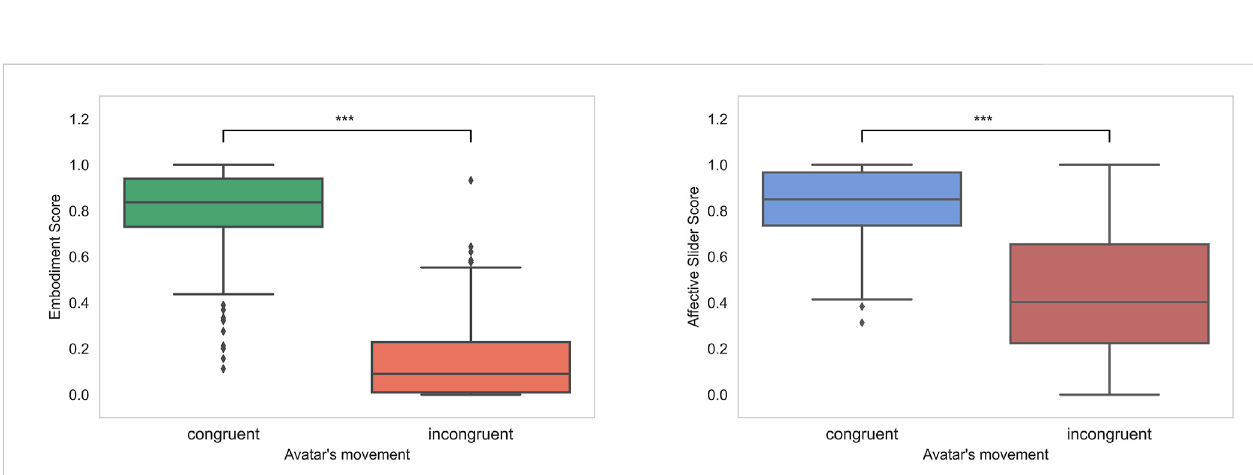
Frontiers in Virtual